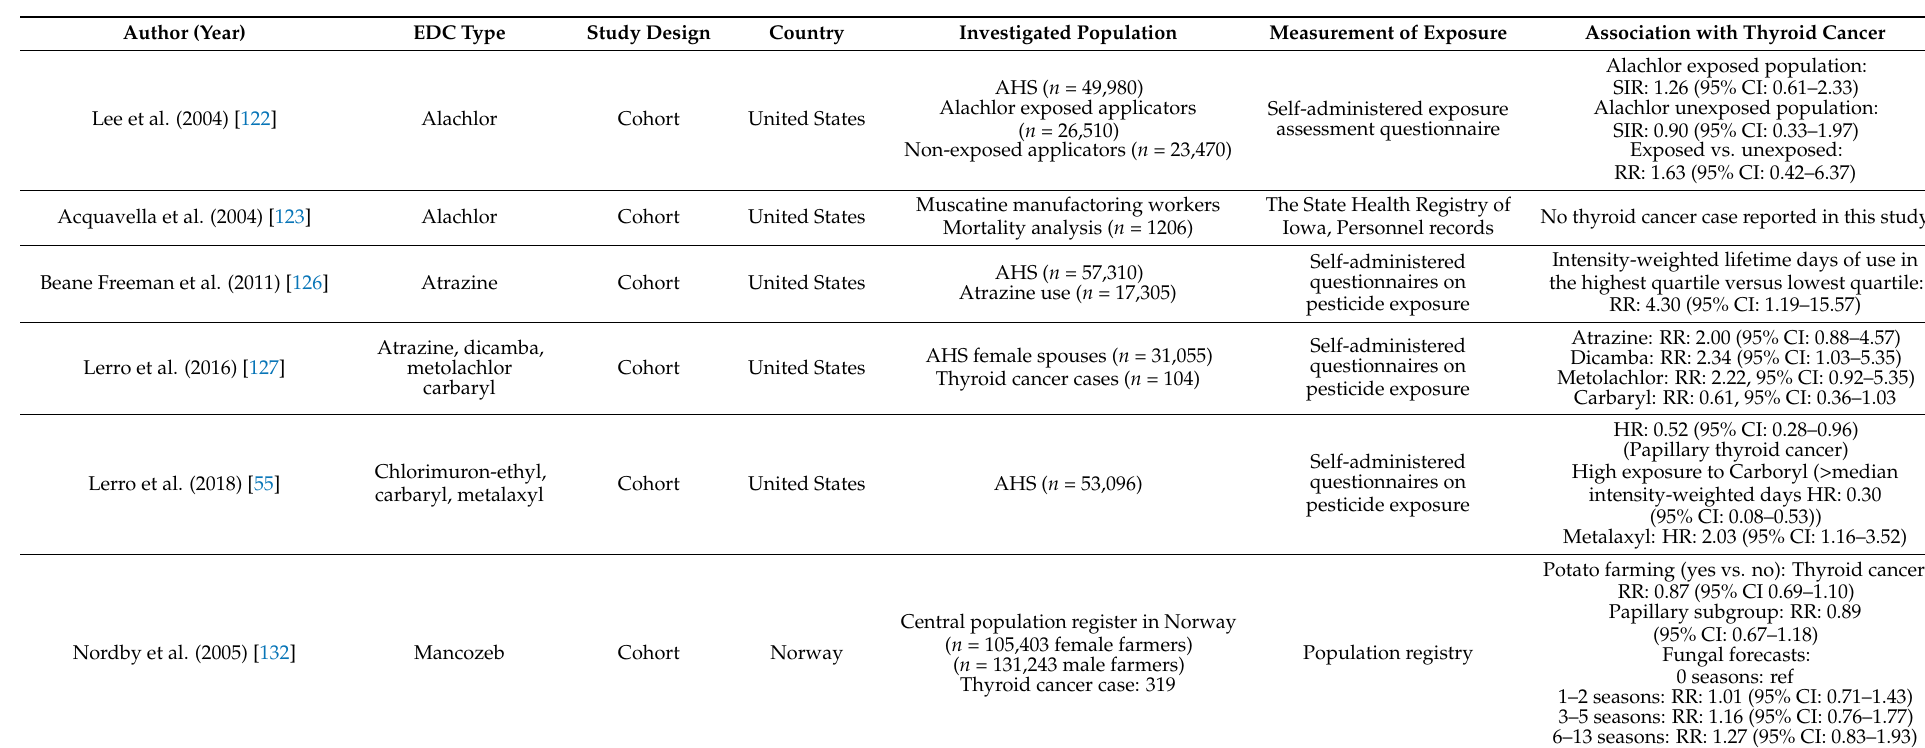
Table 7. Association between exposure to other pesticides and thyroid cancer. Abbreviations: AHS: Agricultural Health Study; CI: confidence interval; EDC: endocrine disrupting chemicals; HR: hazard ratio; RR: risk ratio; SIR: standardized incidence